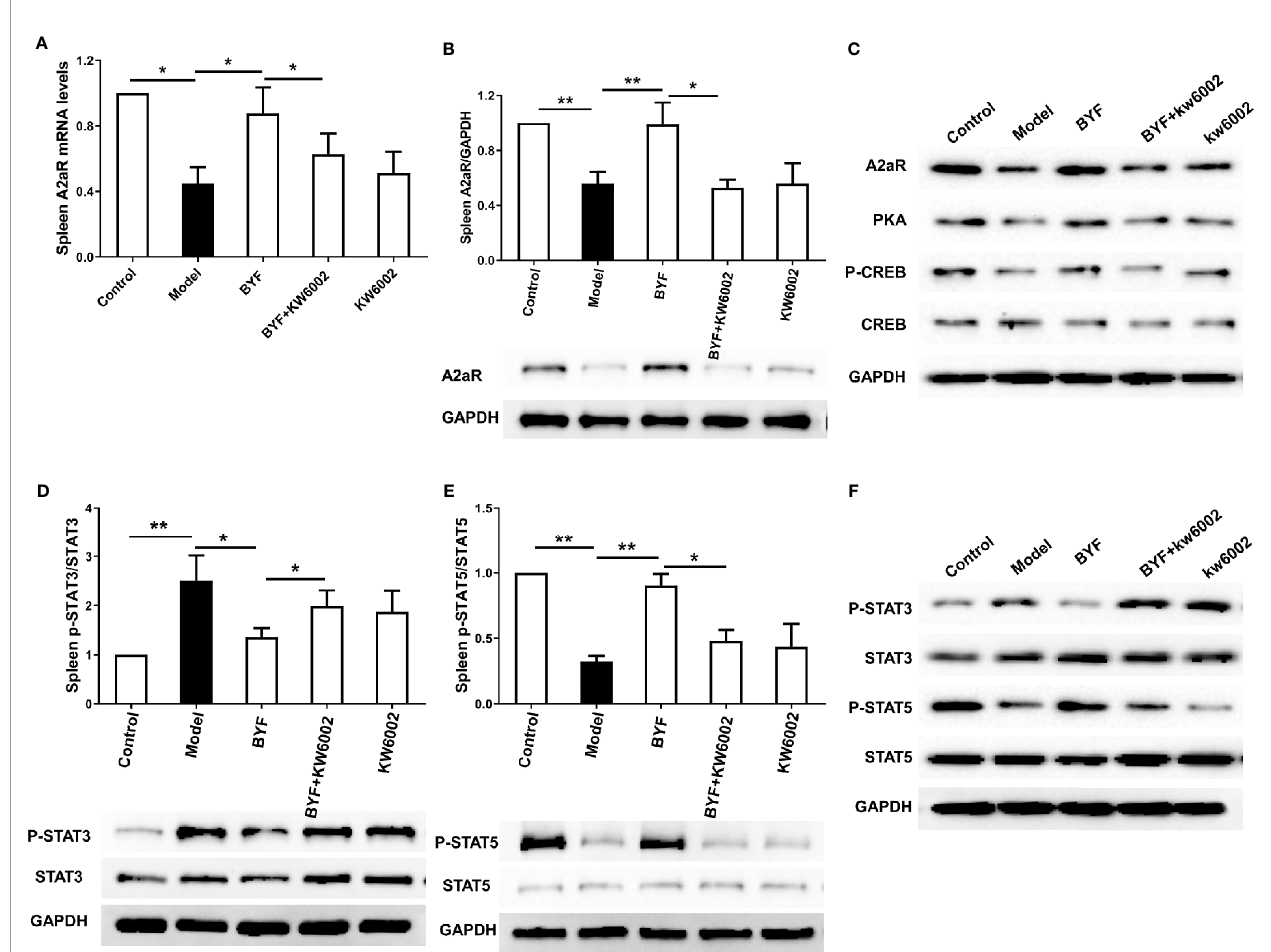
FIGURE 8 | Effect of cotreatment of Bufei Yishen formula (BYF) and A2aR antagonist on expression of A2aR and the phosphorylation of STAT3 and STAT5 in the spleens of chronic obstructive pulmonary disease (COPD) rats. The mRNA level of A2aR in spleen was detected (A) . Expression of A2aR in spleen (B) and A2aR signal proteins including A2aR, protein kinase A (PKA), p-CREB, and CRE binding (CREB) in lung proteins (C) were analyzed by western blotting; p-STAT3/STAT3 (D) , p-STAT5/STAT5 (E) in spleen and in lung (F) were analyzed by western blotting. Data was showed as the means ± SEM (n=6 mice per group). *P < 0.05, **P <